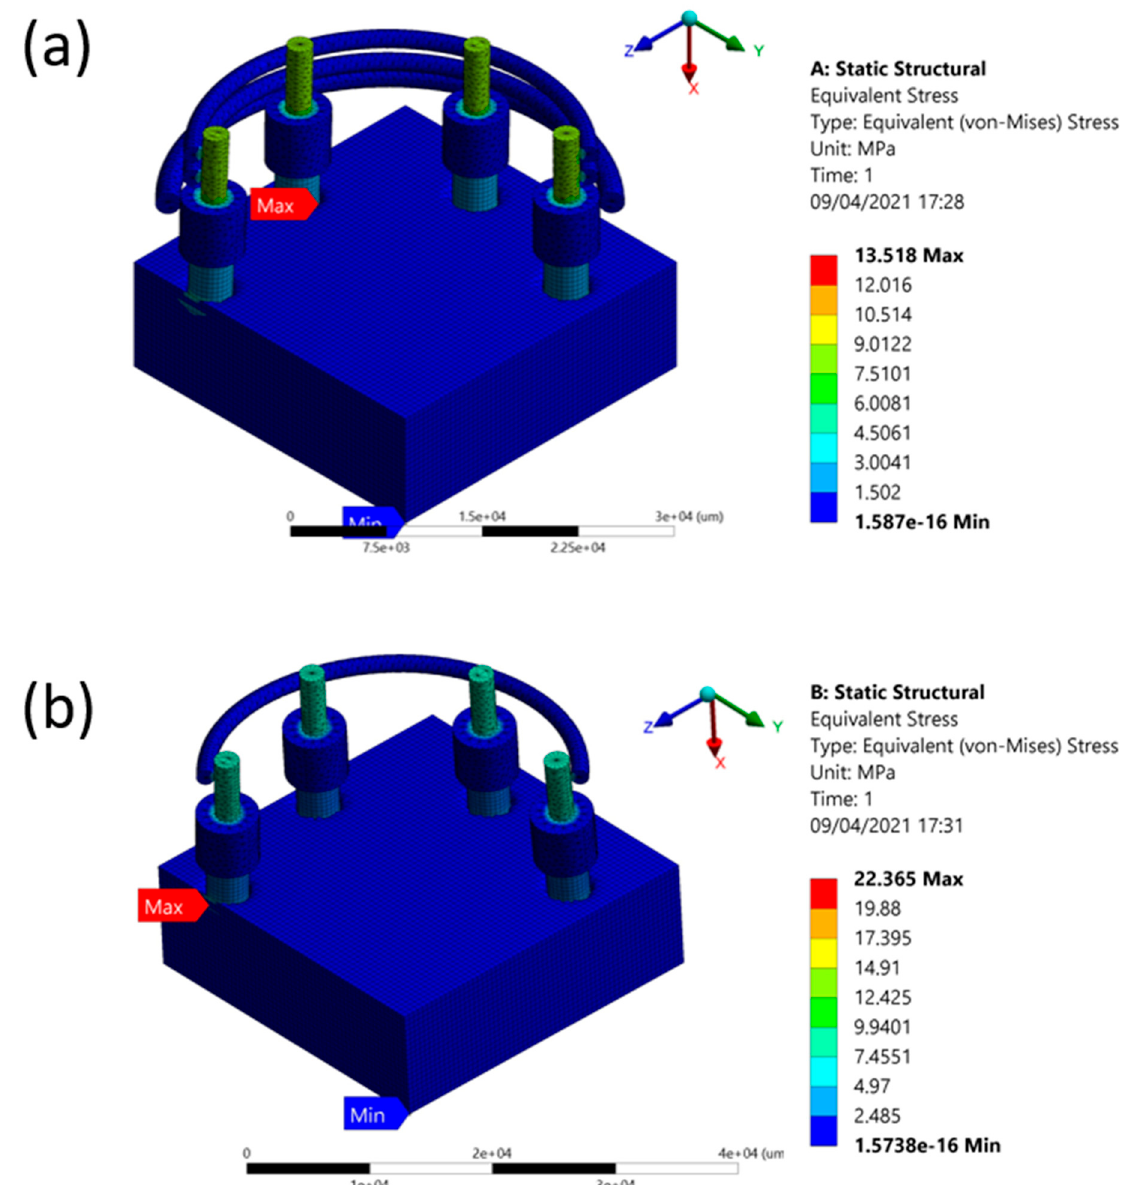
Figure 2. ( a ) Stress when using three fences. ( b ) Stress when using one fence. However, the same design was also tested at an angular force of 100 N at 35 ◦ along the x -axis. The results of the deformation and stress are given in Tables 4 and 5, respectively. Similar to the vertical loads, the von Mises stress found in the three-fenced model was significantly less than that in the one-fenced model (see Supplementary, Videos S7 and S8 for the equivalent von Mises stress when using the three-fenced and one-fenced implants, respectively, for an angular load of 100 N). The maximum deformation found in the one- fenced model was 171.95 µ m, while that in the three-fenced model was 169.04 µ m (see Supplementary, Videos S9 and S10 for the total deformation of the three-fenced and one- fenced models, respectively, for an angular load of 100 N). The maximum stress found in the three-fenced model was 245.34 MPa, whereas that in the single-fenced model was 320.7 MPa. A significant reduction in stress by 85 MPa and maximum deformation by 3 µ m was observed. Despite the significant increase in deformation and stress from a vertical load while an oblique load is applied, the three-fenced model still had less stress and deformation compared with the single-fenced